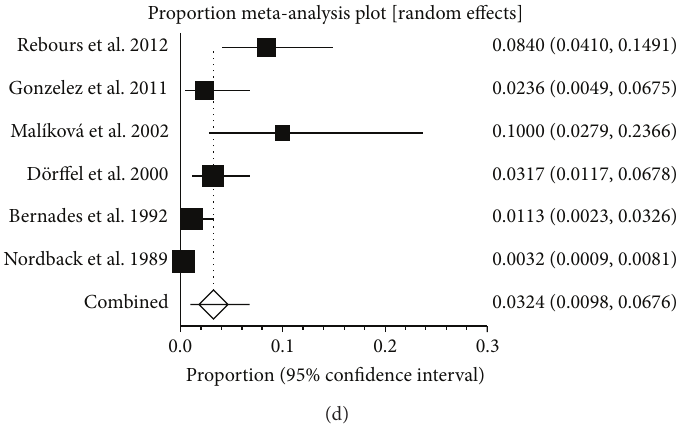
Figure 8: (a) Forest plots showing the prevalence of splanchnic vein thrombosis (SVT) in Europe. (b) Forest plots showing the prevalence of portal vein thrombosis (PVT) in Europe. (c) Forest plots showing the prevalence of splenic vein thrombosis (SlpVT) in Europe. (d) Forest plots showing the prevalence of mesenteric vein thrombosis (MVT) in